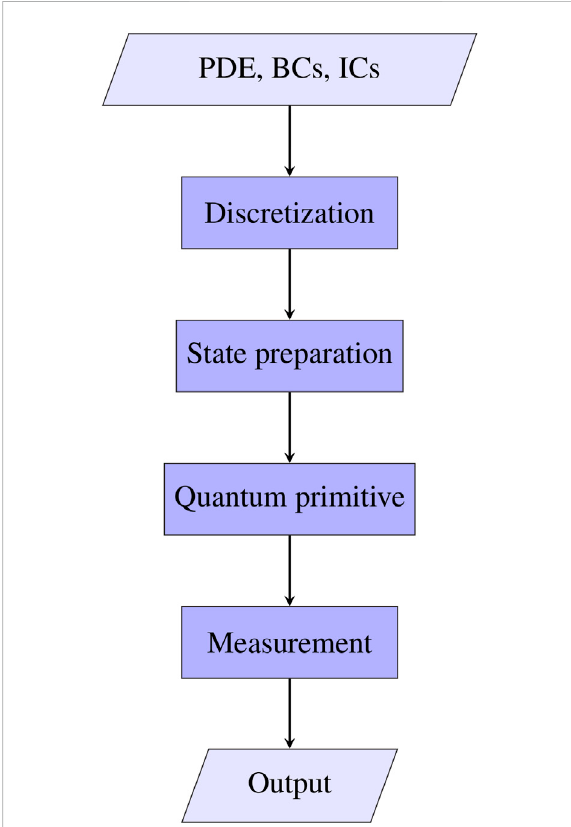
FIGURE 1 Work fl ow of the process of solving partial differential equations with a quantum primitive. The input is given, in the general case, by the PDE together with its boundary (BCs) and initial (ICs) conditions. After the differential problem has been discretized with schemes such as fi nite elements or fi nite differences, the input data is encoded into a quantum state (state preparation step). The quantum primitive then produces the solution to the discrete problem as a quantum state. However, the information in this state cannot be accessed, as this is generally in quantum superposition. Therefore, quantum PDE solver also needs to measure the state after the quantum primitives as many times as required by the user-de fi ned solution precision. Depending of the application, such measurement are postprocessed to provide the fi nal